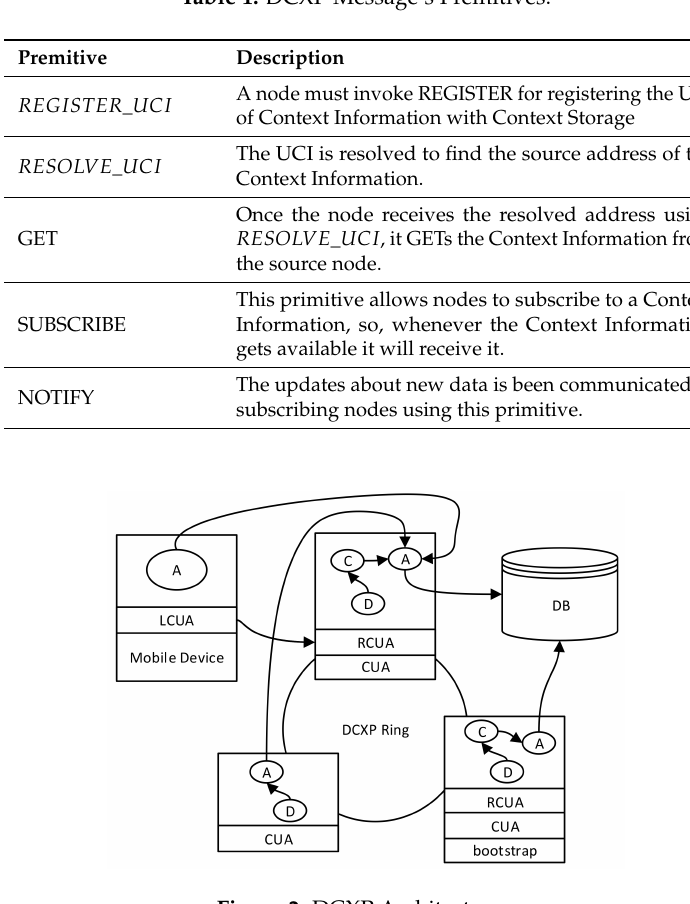
Table 1. DCXP Message’s